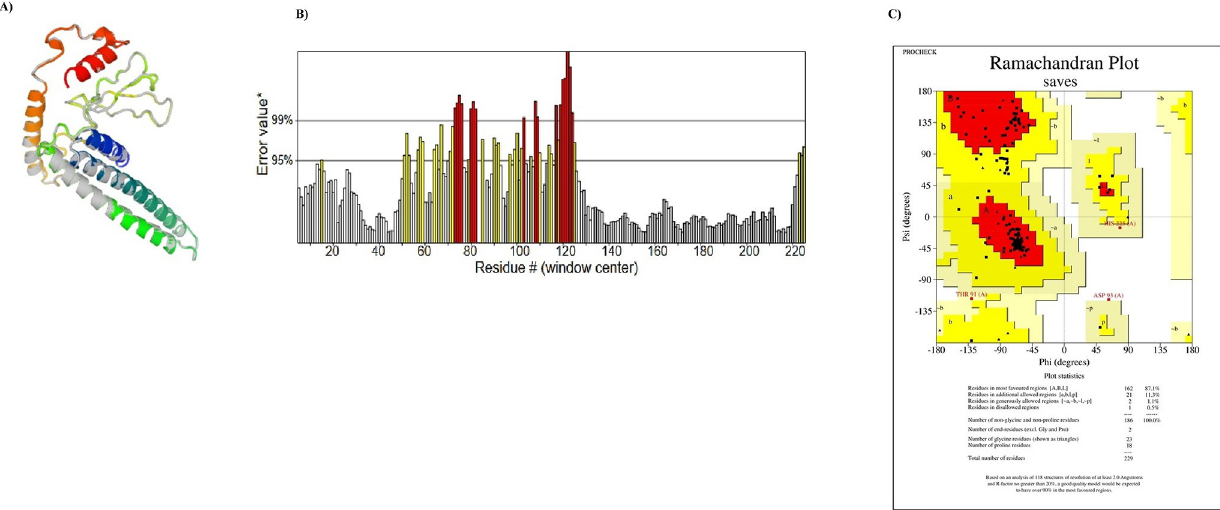
Fig 2. Refined characteristics of the designed construct: A) Refined 3D prediction of the designed construct: The C-terminal and the N-terminal of protein were shown as red and blue color, respectively; B) Overall quality of refinement: The red and yellow bars show error rate in predicted 3D structure. The yellow bars are errors that need to be rejected at a confidence level greater than 95%. The red bars are errors that need to be rejected at a confidence level greater than 99%; C) Ramachandran